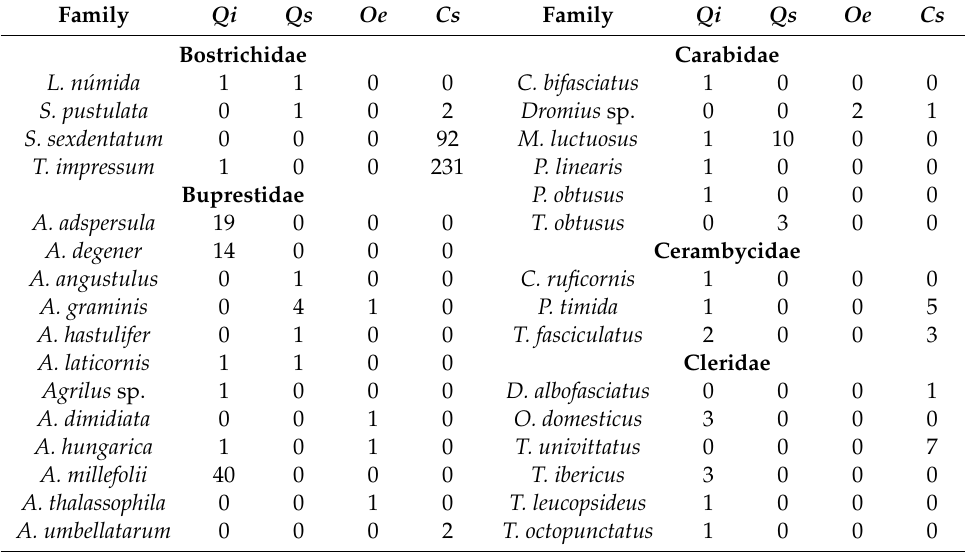
Table 4. Species of saproxylic beetles recorded indicating for each of them the number of specimens, the tree species of provenance, and the family they belong to. (Cs: C. siliqua; Oe: O. europaea ; Qi: Q. ilex ; Qs: Q. suber